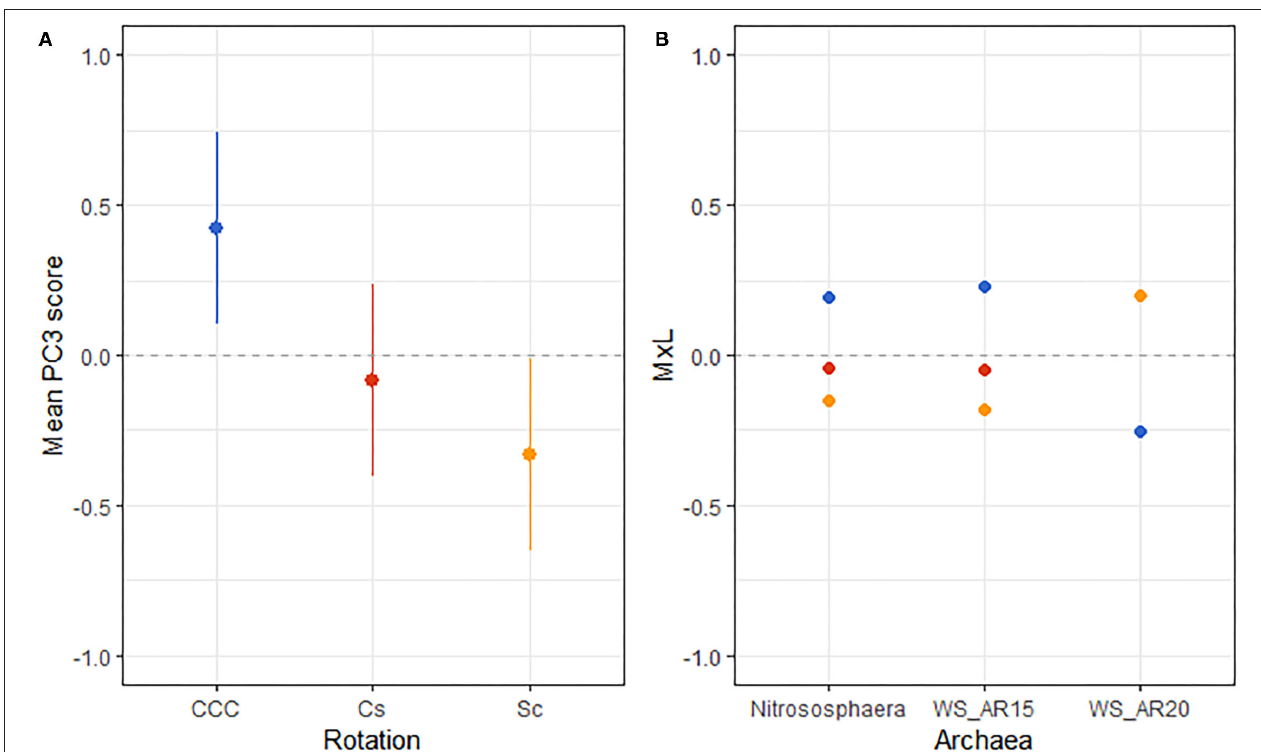
FIGURE 1 | (A) Mean value of the archaeal PC3 for each rotation treatment with their standard errors (as whiskers). (B) Contribution of each indicator archaeon to the PC mean value (MxL) for each rotation treatment: continuous corn (blue), corn phase of the corn-soybean rotation (red), and soybean phase of the corn-soybean rotation